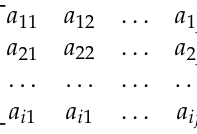
Table 4. Calculation results of the weight of the comprehensive evaluation index of rock burst hazard. Index I Index-Weight α i I 1 Microseismic event energy 0.30 I 2 Dominant frequency 0.20 I 3 Dominant frequency amplitude 0.05 I 4 Wavelet packet decomposition 0.10 0.10 I 6 Instantaneous energy 0.05 I 7 Acoustoelectric index